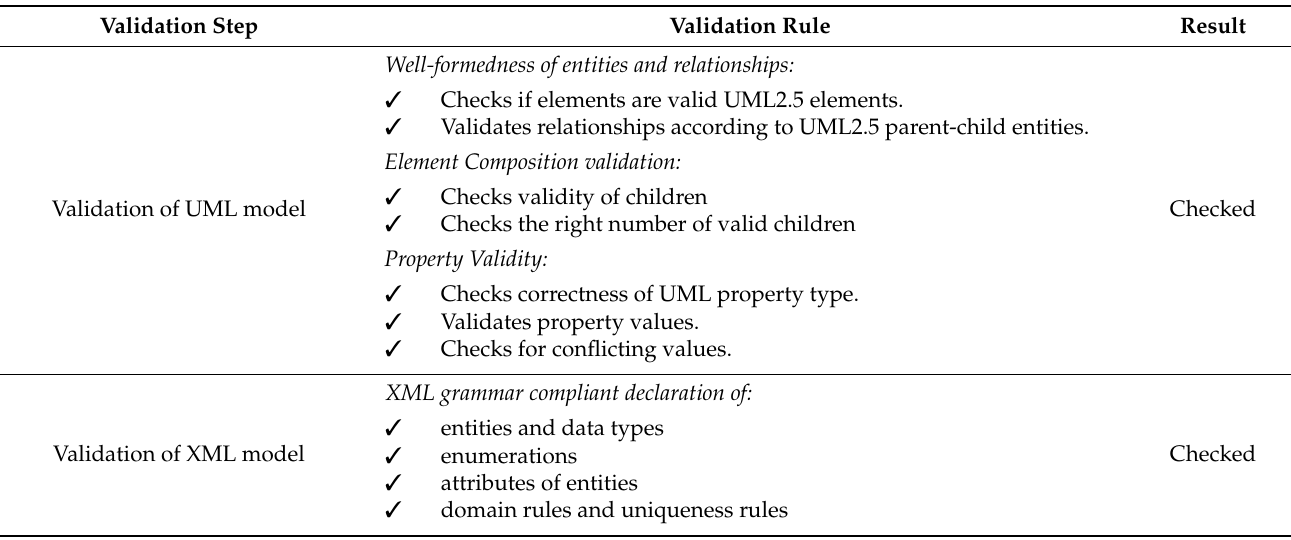
Table 8. IFCInfra4OM Syntactical Validation